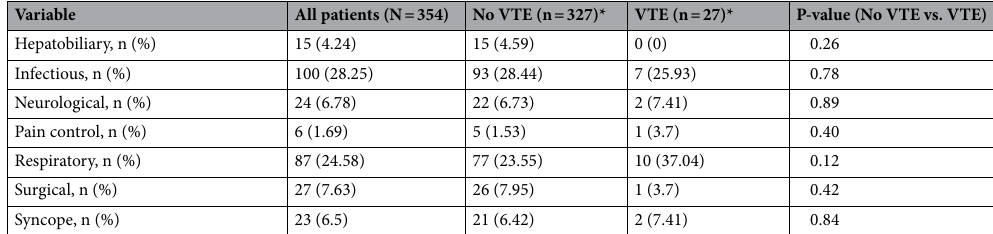
Table 1. Baseline characteristics of all hospitalized patients with a positive age-adjusted D-dimer test. Significant values are in bold. *VTE and "No VTE" are defined as venous thromboembolism definitively diagnosed during the hospital admission or within 3 months of discharge. VTE venous thromboembolism, DIC disseminated intravascular coagulopathy, PICC peripherally inserted central